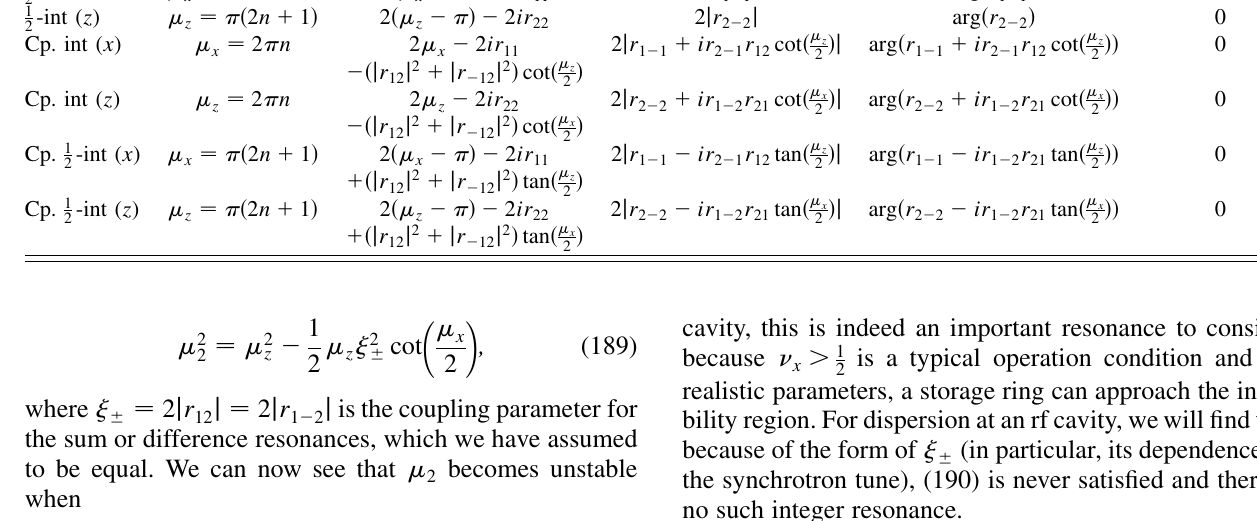
TABLE I. Linear resonances of a synchrobetatron coupled storage ring. For each of the linear resonances, we give general expressions for the quantities (cid:2) (cid:6) , (cid:4) , (cid:9) , and (cid:3) (cid:6) . The quantities r perturbation P . We have left off the subscript (cid:4) for convenience. The matrix elements r (cid:4) are included explicitly in the (cid:2) (cid:6) and involve (cid:6) calculation for the coupling-induced integer and half-integer resonances (see Appendix D).